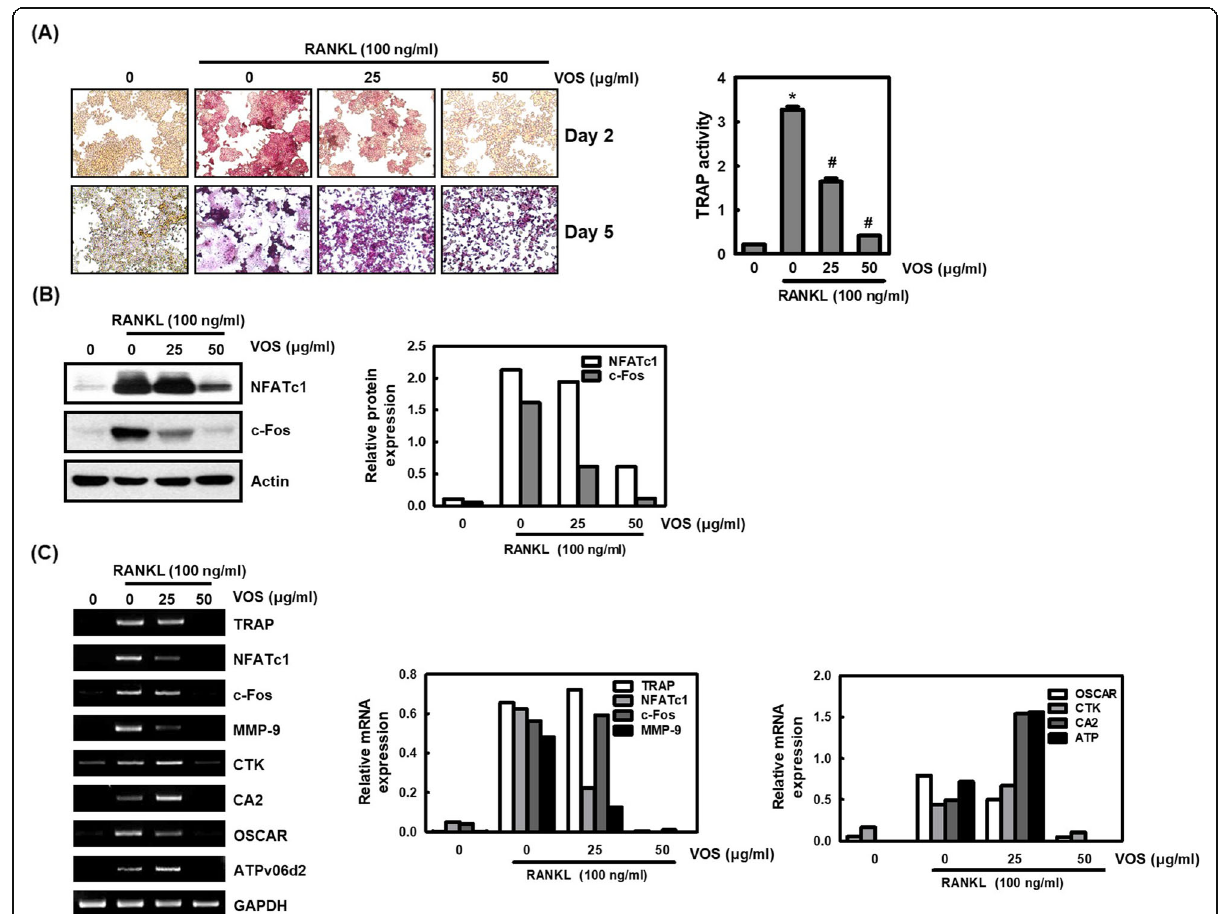
Fig. 5 Effect of VOS on osteoclast differentiation. a Effect of VOS on osteoclastogenesis and resorptive activity. The cells were stained with the TRAP assay kit, and media were collected for the TRAP activity. TRAP-positive multinuclear cells were captured using an inverted microscope (100×, Scale bars: 200 mm). The media were measured for TRAP activity by an ELISA reader. b Effect of VOS on the activation of NFATc1 and c- Fos by RANKL. NFATc1 and c-Fos protein expressions were determined by western blot. Expressions of NFATc1 and c-Fos were normalized to actin. c Effects of VOS on the mRNA expression of osteoclastogenesis marker genes by RANKL. The mRNA expressions were detected by RT-PCR and normalized to GAPDH. Columns and error bars represent the mean ± S.D. of three independent experiments. The density of mRNA bands was calculated using the software UN-SCAN-IT gel version 5.1 (Silk Scientific Inc. Orem, UT, USA). *P < 0.05 compared to the cells without the treatment, and # P < 0.05 compared to the cells treated with RANKL